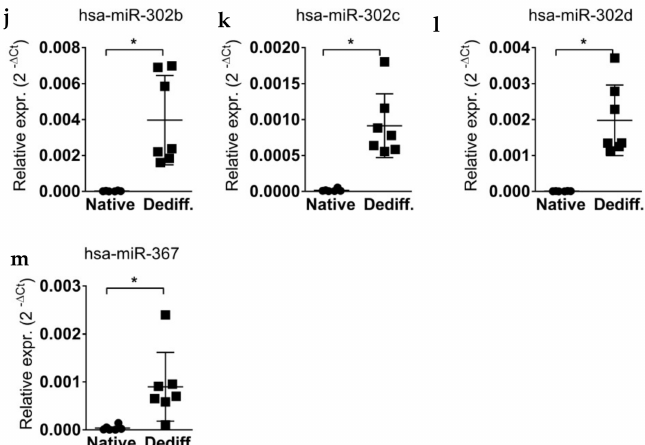
Figure 2. Validation of differentially expressed microRNAs in dedifferentiated islet cells. Stem–loop RT-qPCR single assay validation of 13 identified upregulated microRNAs in dedifferentiated human pancreatic islet cells. Single assay RT-qPCR validation of n = 6 native human islets and n = 7 islet-derived mesenchymal cells of miR-99a ( a ), miR-100 ( b ), miR-137 ( c ), miR-337-3p ( d ), miR-708 ( e ), miR-214 ( f ), miR-199-3p ( g ), miR-199-5p ( h ), miR-302a ( i ), miR-302b ( j ), miR-302c ( k ), miR-302d ( l ), and miR-367 ( m ) . Data are reported as normalized 2 − ∆ C t values together with mean ± SD. Mann–Whitney U test, * p < 0.05.